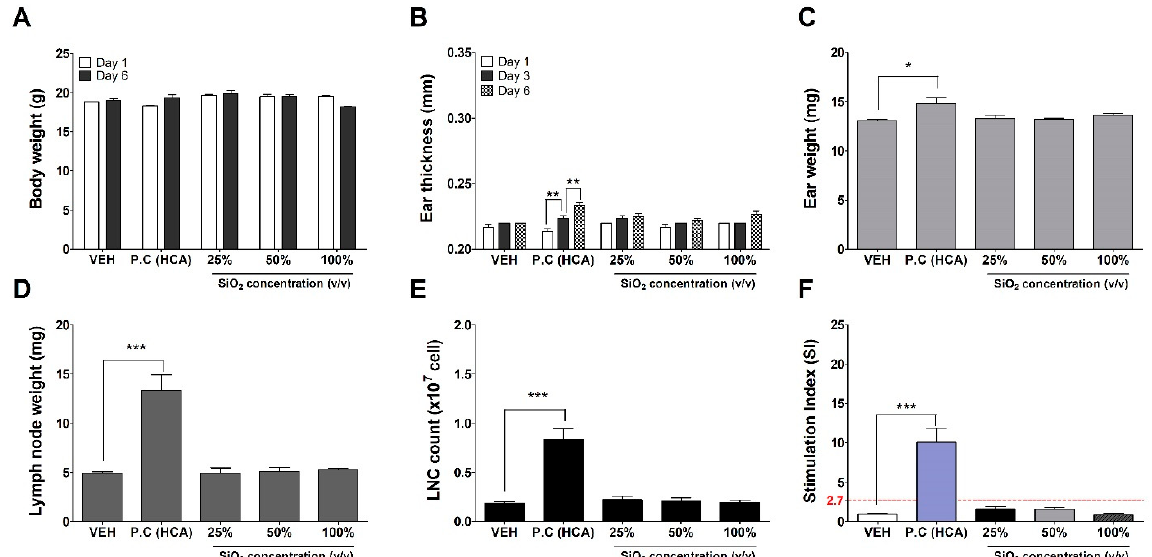
Figure 6. Results of silica NPs skin sensitization potential in LLNA: BrdU-FCM. The dispersed silica NP’s suspension (working concentration: 25, 50, and 100% v / v , respectively), vehicle control (DMF contained 3% mouse serum) and positive control (25% HCA) were applied to the dorsal skin of each ear of the mouse. The evaluation parameters were as follows: ( A ) Body weight (g), ( B ) Ear thickness (mm), ( C ) Ear weight (mg), ( D ) Lymph node weight (mg), ( E ) Number of lymph node cell ( × 10 7 cells), and ( F ) Stimulation Index (SI). Data are expressed as mean ± SEM ( n = 4). * p < 0.05, *** p < 0.0001 compared to vehicle control group (The ear thickness values were compared on days 1–3 and 3–6 after administration, ** p < 0.001). VEH = vehicle control, P.C = positive control, HCA = hexyl cinnamic aldehyde.